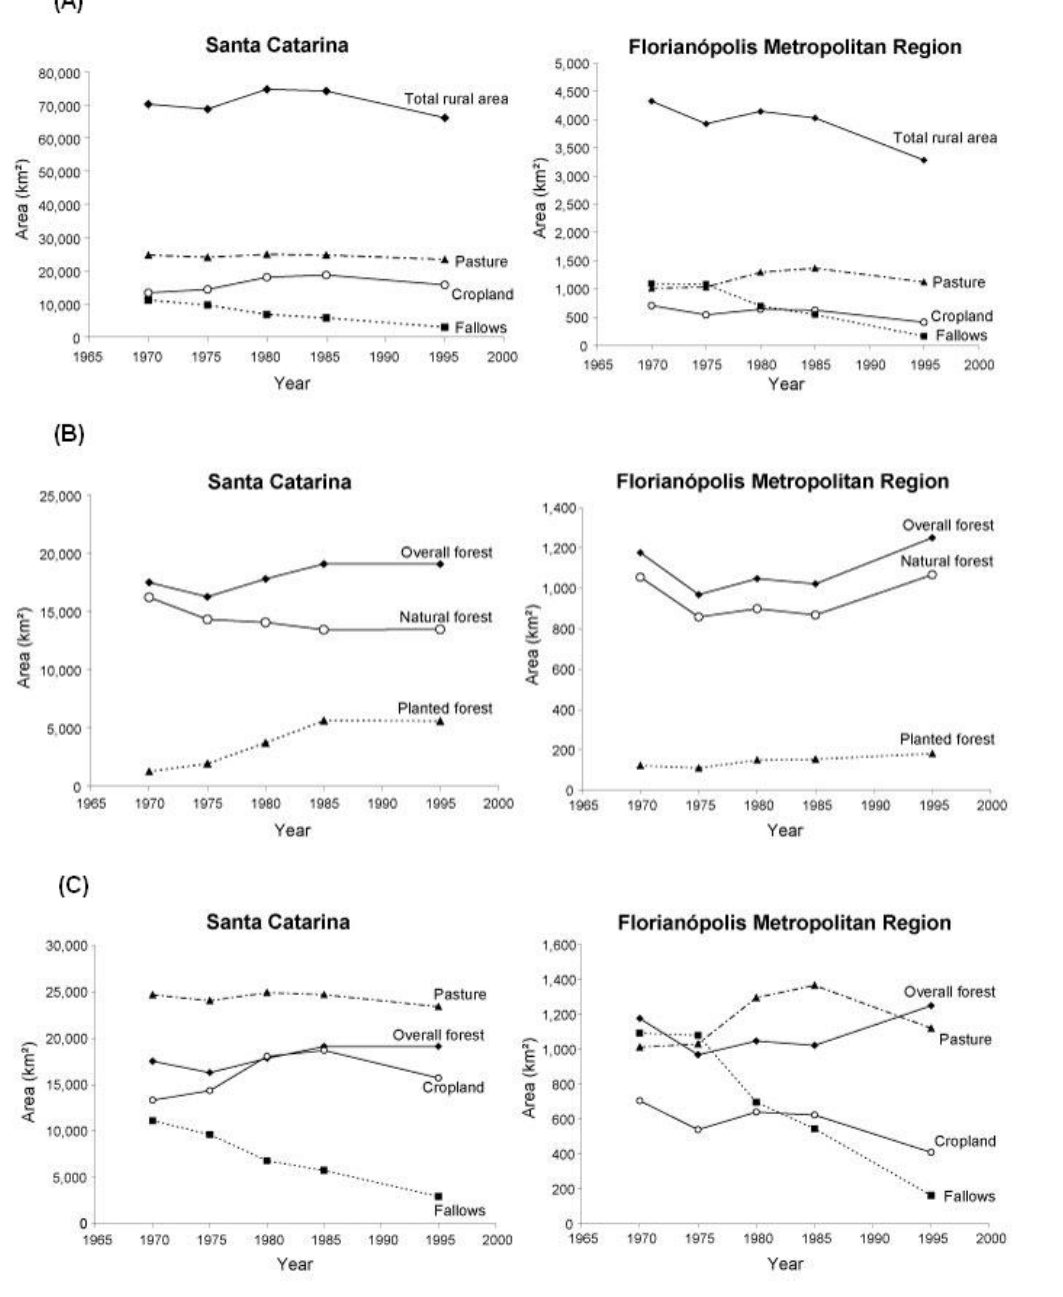
Fig. 6. Land-use change on rural private property in Santa Catarina and the Florianópolis metropolitan region from 1970 to 1995–1996. Change in (A) total rural area, pasture, cropland, and fallow; (B) forest types; and (C) forest, pasture, cropland, and fallow. Source: Instituto Brasileiro de Geografia e Estatística (1974 a, 1979, 1983 a, 1990,